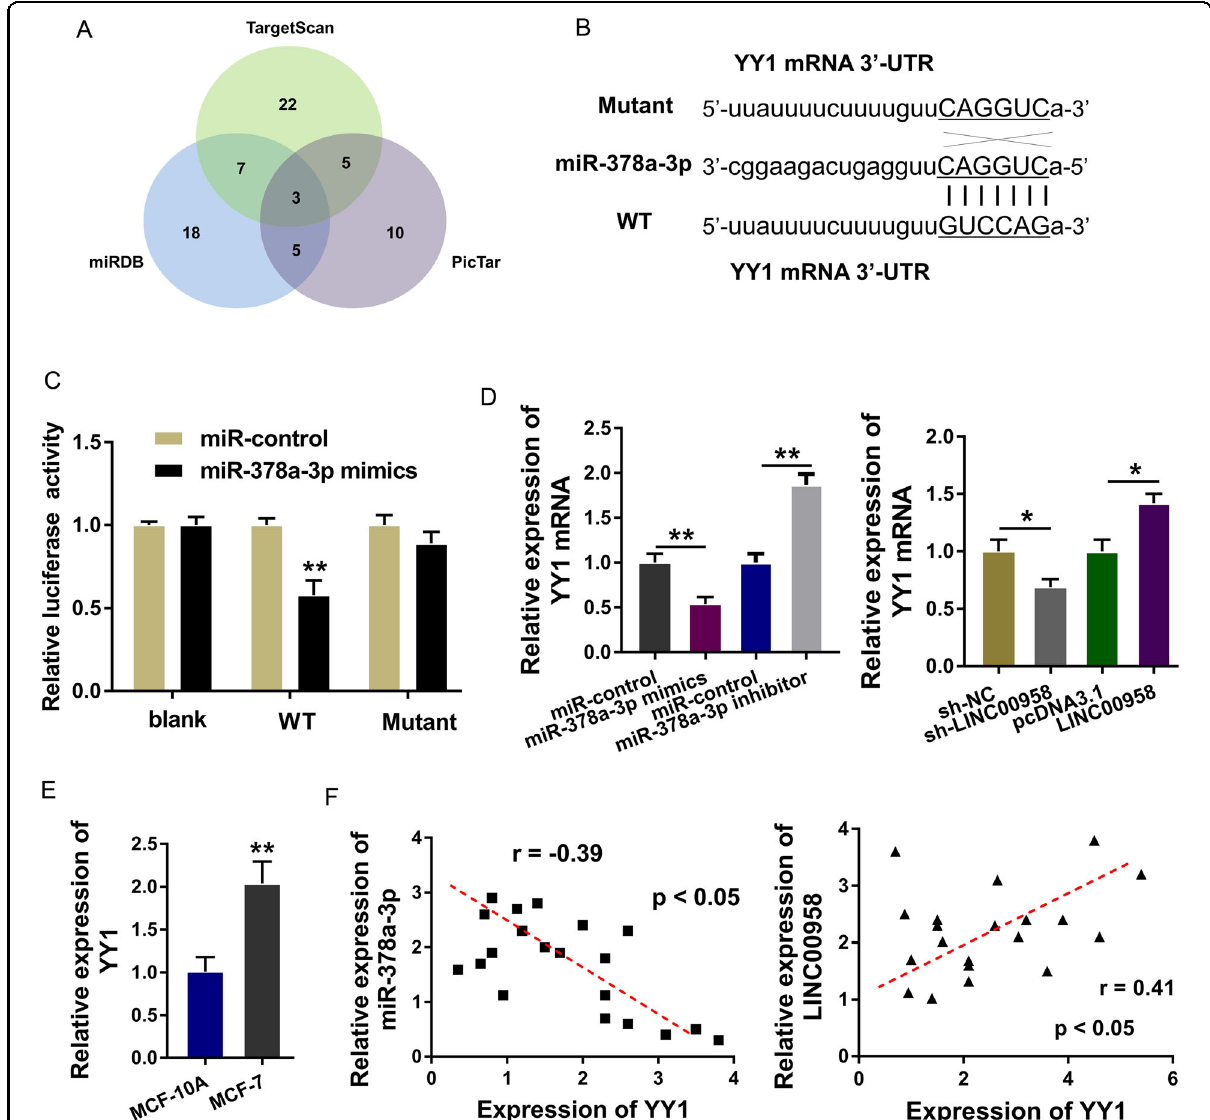
Fig. 5 LINC00958/miR-378a-3p targeted YY1. A Bioinformatics predictive tools (TargetScan, miRDB, PicTar) identi fi ed multiple proteins that could be targeted by LINC00958/miR-378a-3p. B Luciferase reporter vectors for YY1 mRNA (wild type and mutant) were synthesized. C Luciferase gene reporter assay found that miR-378a-3p mimics/control connected with the YY1 mRNA wild type/mutant. D RT-PCR analysis found YY1 mRNA in MCF- 7 cells transfected with miR-378a-3p mimics/inhibitor or LINC00958 knockdown/overexpression. E T-PCR analysis showed YY1 mRNA expression in MCF-7 cells and normal cells (MCF-10A). F Correlation analysis using Pearson ’ s χ 2 method indicated the correlation with YY1 and